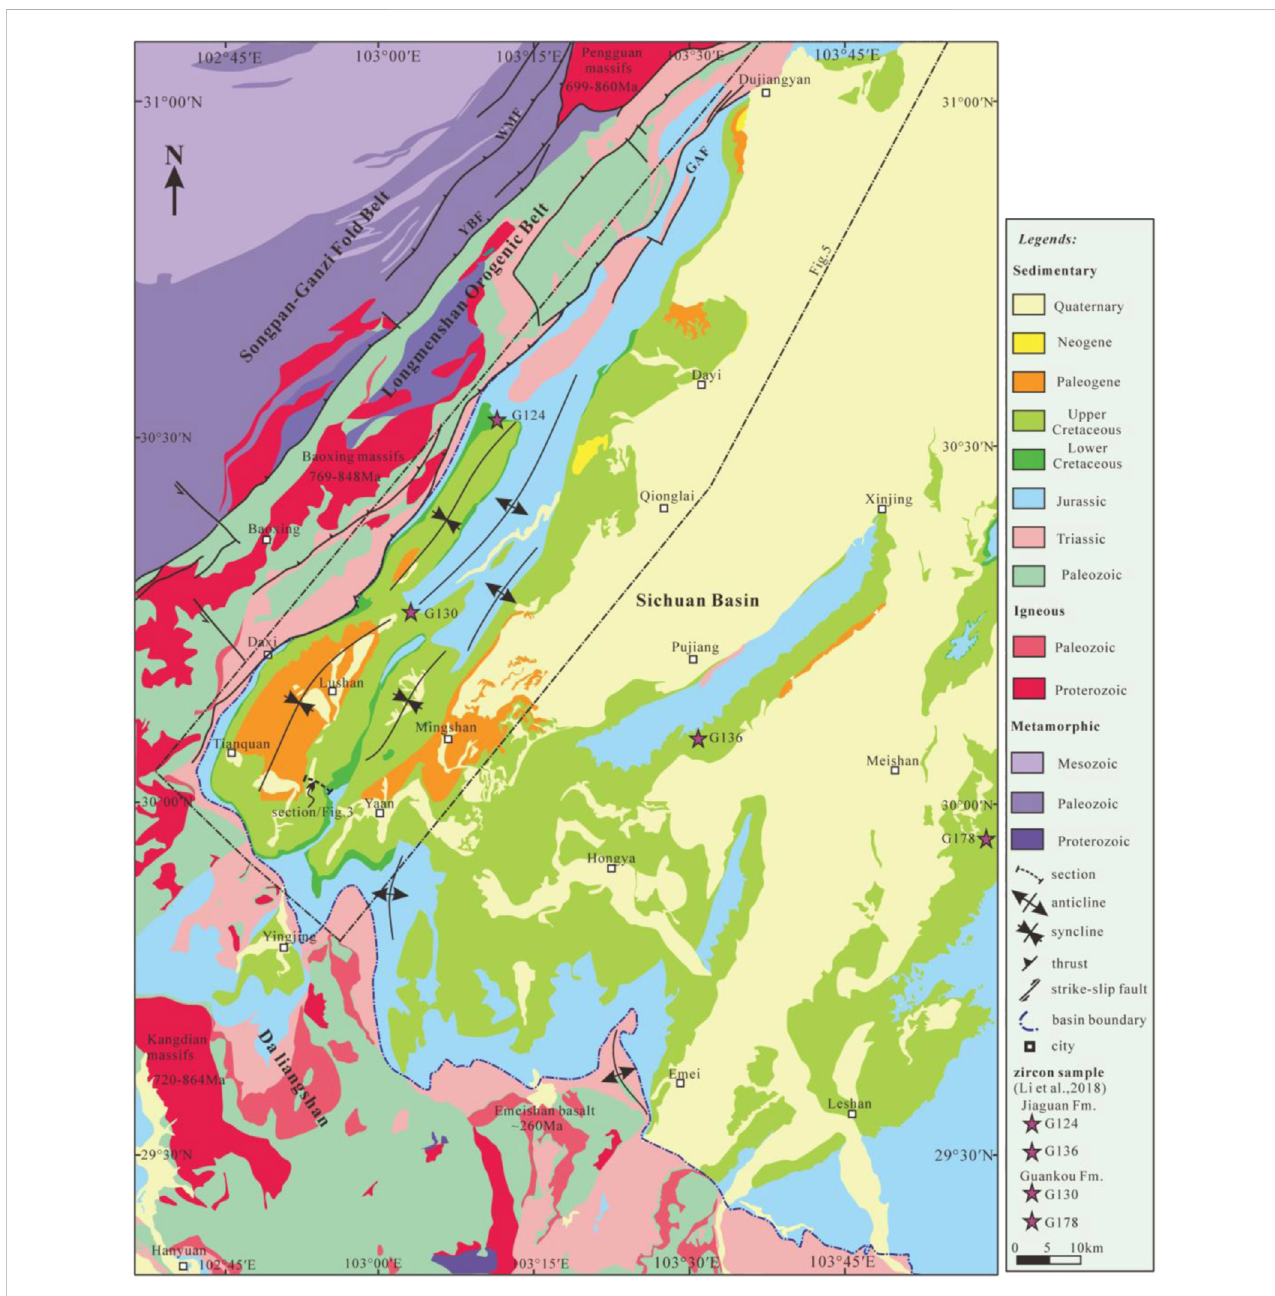
FIGURE 2 Geological map of the southwestern corner of the Sichuan basin showing the location of measured sections and sampling localities. Geology map modi fi ed after Burch fi el et al. (1995), 1:200,000 geologic maps (Ministry of Geology and Mineral Resources, 1991), and our own observations. WMF- Wenchuan-maoxian fault; YBF- Yinxiu-Beichuan fault; GAF- Guanxian-Anxian